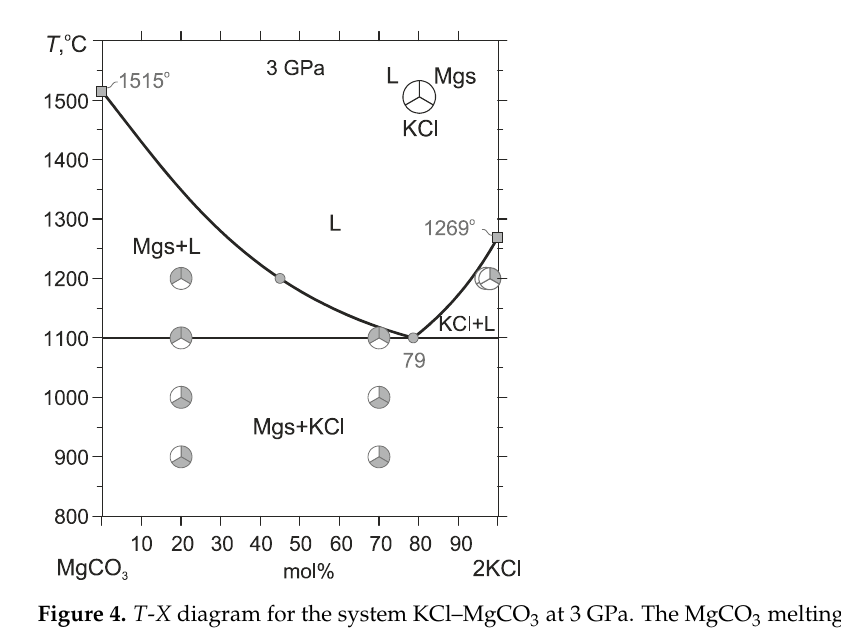
Figure 3. BSE images of sample cross-sections in the system 2KCl–MgCO 3 at 3 GPa and 1000 ( a,b ), 1100 ( c,d ), and 1200 °C ( e,f ). The numbers in parentheses denote the melt K2#. HT—high-tempera- ture side. LT—low-temperature side. The gravity vector is directed downward.